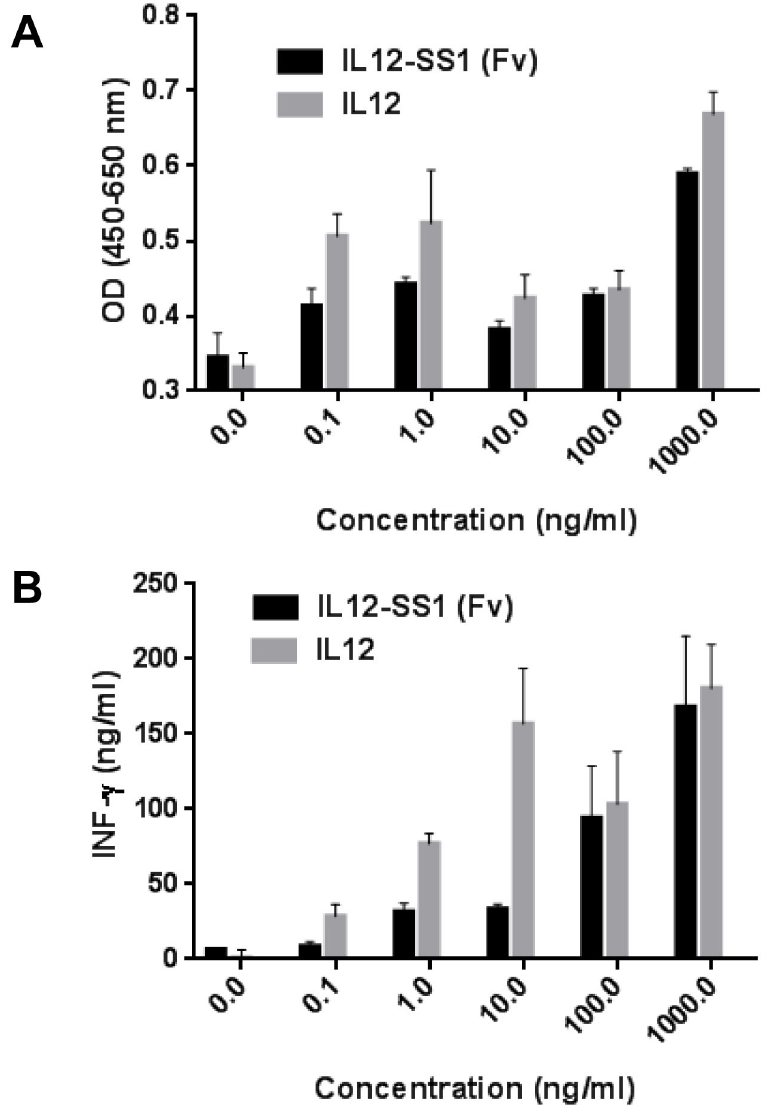
Figure 3. In vitro functional analysis. Peripheral blood mononuclear cells (PBMCs) were isolated from buffy coat and activated by 10 µg/ml of PH-A for 4 days. The IL12 activity assay was performed with PBMCs in the presence of murine recombinant IL12 (mIL12) or IL12-SS1 (Fv) fusion proteins for 4 days. (A) Cell proliferation was monitored by a colorimetric assay (WST-8). (B) INF-γ in the supernatant was detected by Human IFN-γ Quantikine ELISA Kit (R&D Systems). doi: 10.1371/journal.pone.0081919.g003 group except white blood cells; the organ weights of IL12-SS1 (Fv) treated-mice were not significantly different from those of the control group mice, indicating that IL12-SS1 (Fv) has no serious toxicity in mice. We noted that the white blood cells were elevated by about 2-old in the IL12-SS1 (Fv) group (16.28 ± 2.47 K/µL) as compared to the control group (7.1 ± 2.16 K/µL) and the SS1P group (7.51 ± 0.97 K/µL). A larger scale study will be needed to investigate the pharmacokinetics, pharmacodynamics and bio-distribution of IL12-SS1 (Fv).